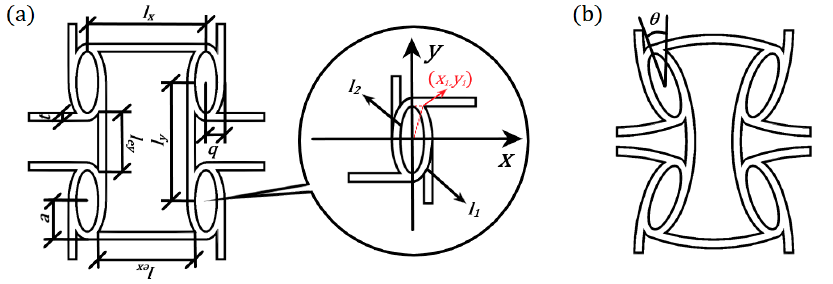
Figure 2. Schematic of E-antitet: ( a ) Unit cell and parameters of E-antitet; ( b ) E-antitet cell defor- mation.